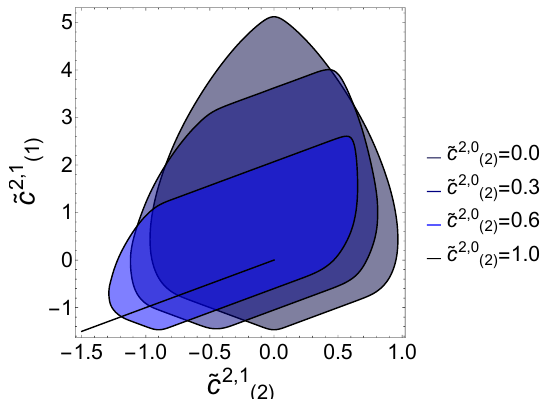
= 4˜ c 2 , 0 = 2˜ c 2 , 1 = 4˜ c 2 , 1 ) for bi-scalar theory with , ˜ c 2 , 1 , ˜ c 2 , 1 1122 1111 1122 (2) (1) (2) = 2˜ c m,n = 0 subspace, agnostic about all higher order coefficients. 1221 (3) ) m t n term in the ij → kl amplitude, and the 2 . We choose units such that the cutoff Λ = 1 . We ≡ c m,n /c 2 , 0 ( a ) ( a ) (1)